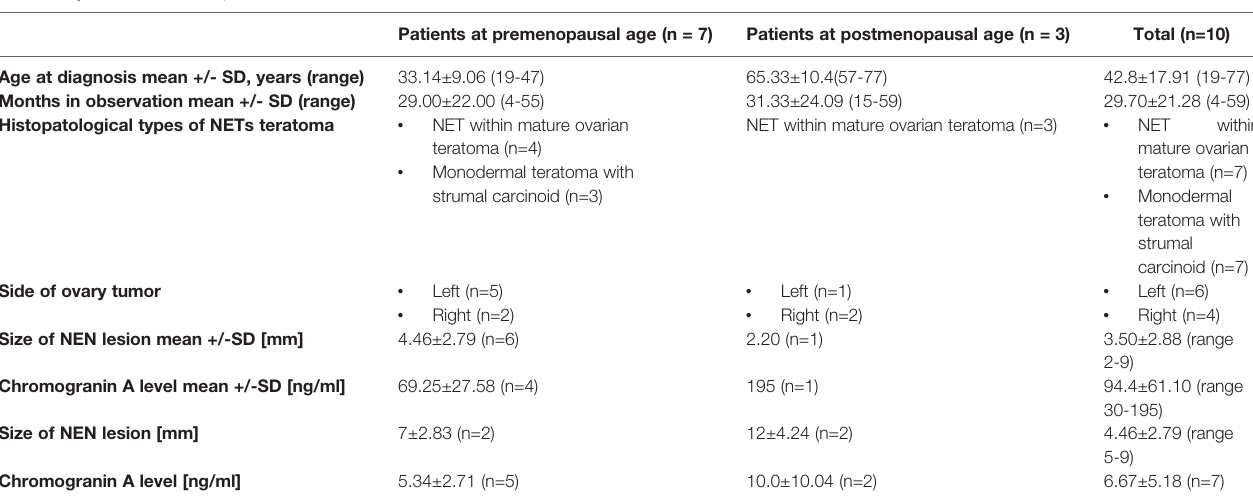
TABLE 1 | Characteristics of patients and excised